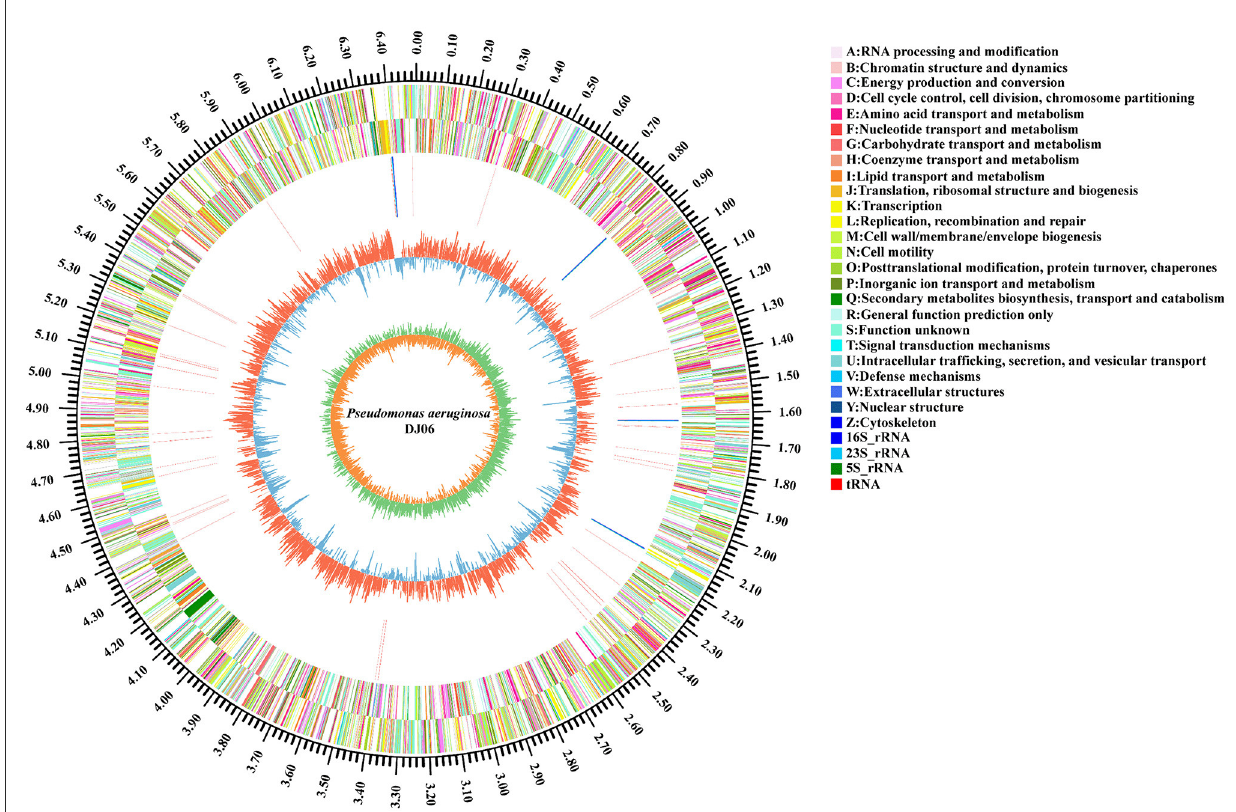
FIGURE2 Circular representation of chromosome of endophytic bacteria Pseudomonas aeruginosa DJ06 strain isolated from sugarcane root. The inner and innermost rings display the GC content and skew. Circles 1–2 show the functional classification of the CDS genes in the chromosome with the colors of the COG database, and in circles 3, different colors indicate different RNA